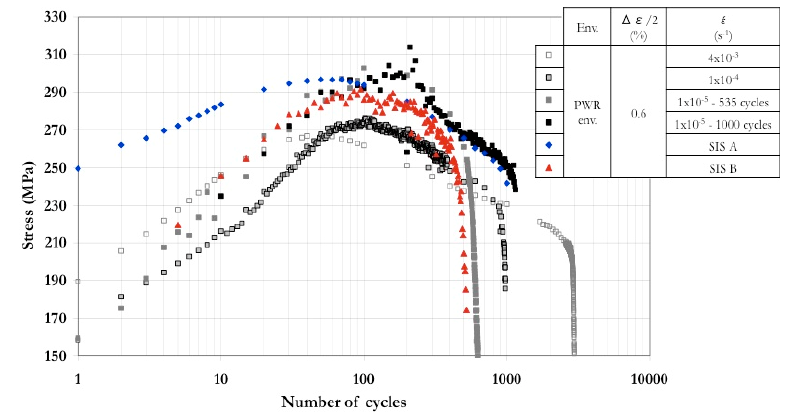
Figure 9. Peak stress as a function of the number of cycles with triangular signals at different strain rates and with SIS A and SIS B signals in the PWR environment.